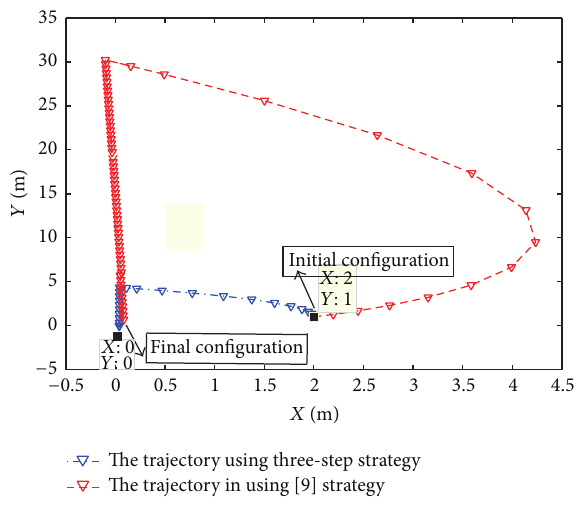
Figure 12: The trajectory of the second group in Table 1.